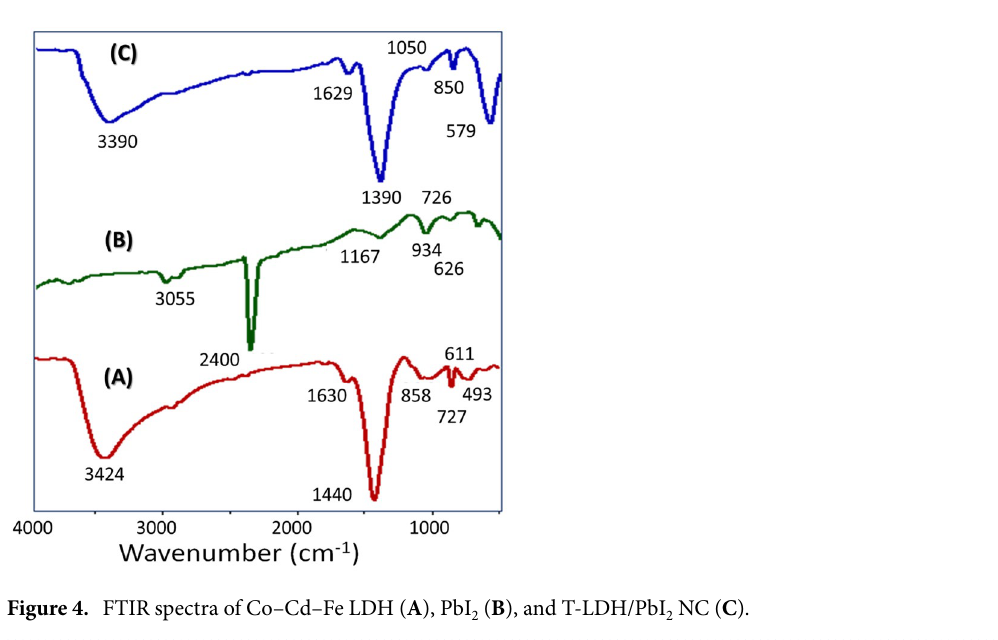
Fig. 4A. The FTIR spectral modes of PbI 2 , Fig. 4B, are ascribed to vibrations of inorganic clusters. The mode at 1490 cm −1 is credited to the H 2 O molecule’s absorption 27 . Figure 4B confirms the presence of strong interactions between Pb–I clusters. Symmetric and asymmetric modes are observed at 3055 and 3700 cm −1 of the Pb–I 28 . The peak at 2400 cm −1 was ascribed to the water stretching region. After the combination, the FTIR spectrum of T-LDH/PbI 2 NC exhibits a shift to lower wavenumbers (redshift) which may be ascribed to the distribution of Pb–I